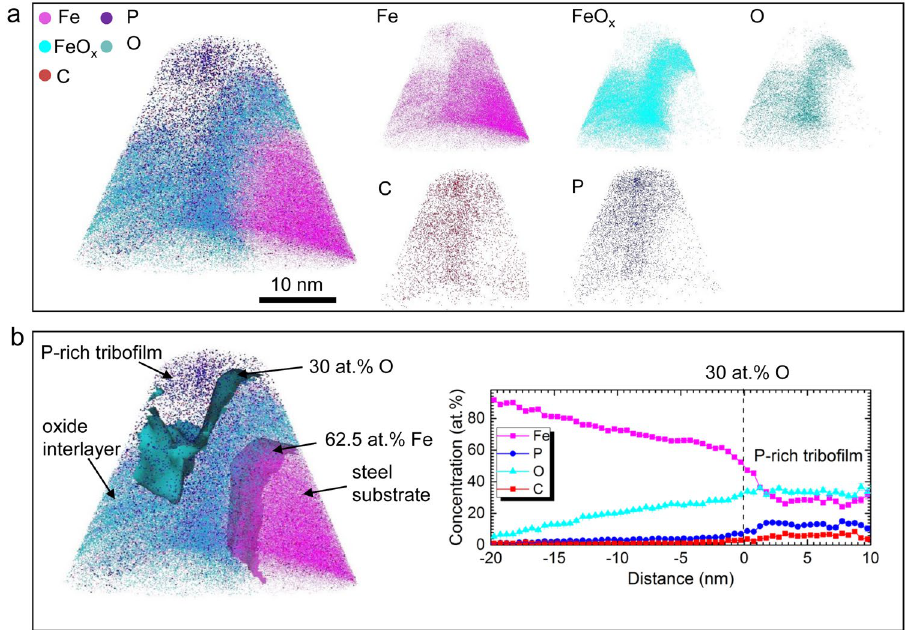
Figure 2. 3D APT reconstruction of the IL tribofilm showing a gradient layered structure. ( a ) Spatial distribution of Fe, FeO x , O, C, and P ionic species. ( b ) Isoconcentration surfaces of 30 at.% O and 62.5 at.% Fe, and the proximity histogram analysis with respect to 30 at.% O isoconcentration